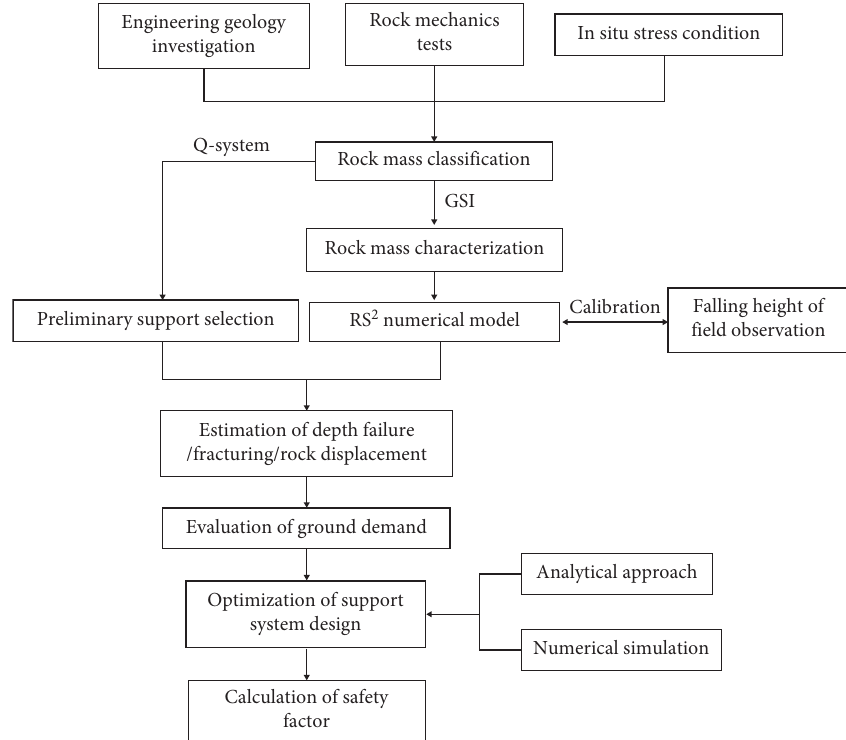
Figure 5: Flowchart of the systematic approach for support design of weak rock drift in Xinli mine.